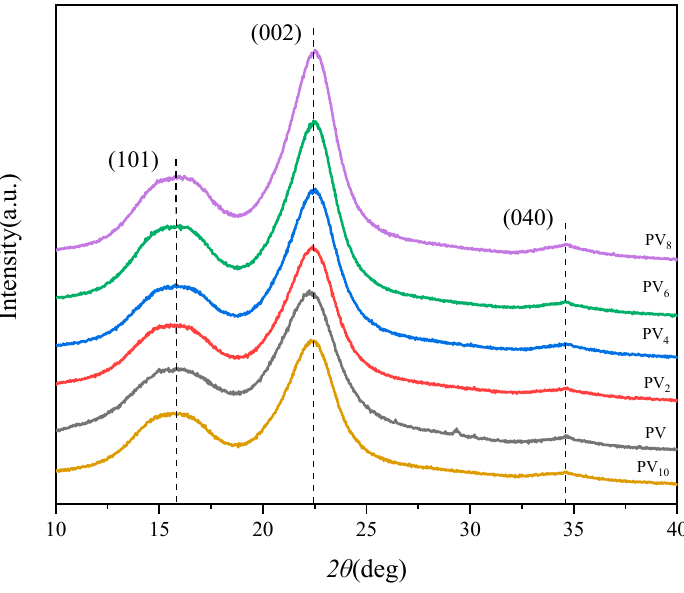
Figure 4. XRD patterns of PVs with different delignification time. Table 2. The relative crystallinity of cellulose for all PVs with different delignification time. Sample